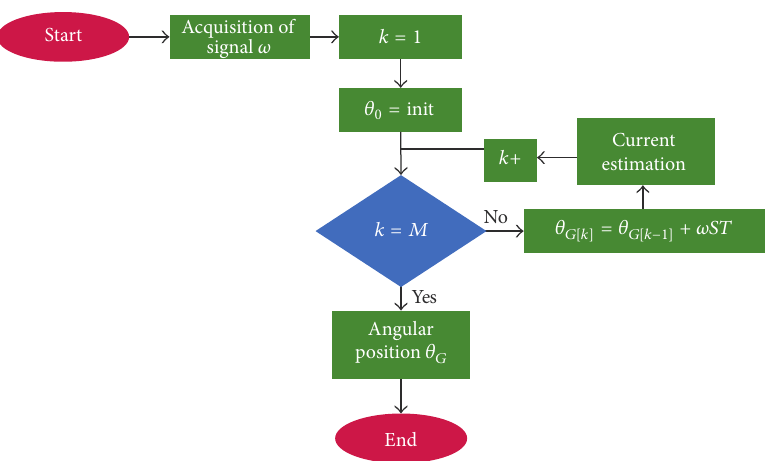
Figure 3: Angular position estimation with